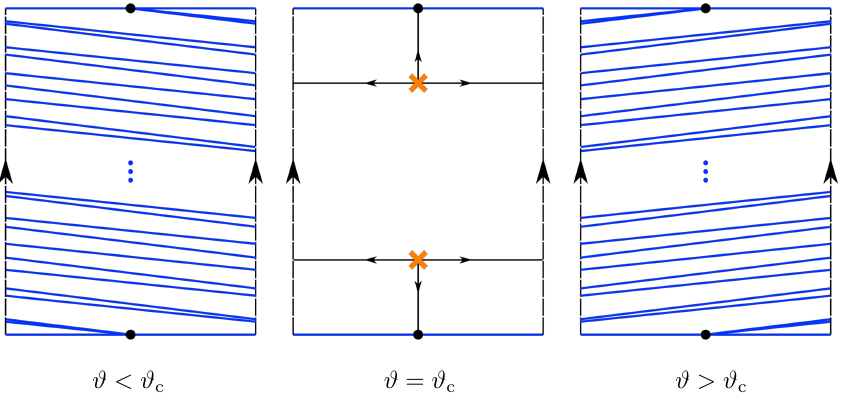
Figure 4 . Triangulations T ϑ for the pure SU(2) gauge theory for ϑ below and above ϑ winding the cylinder. At ϑ = ϑ c the triangulation cannot be defined and we instead draw the Stokes graph, which contains two closed finite curves that lift to γ 1 + γ 2